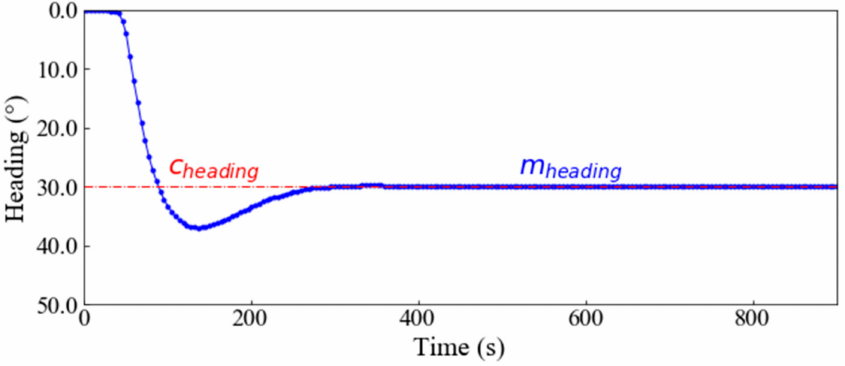
Figure 17. The heading of the glider under the control of a heading controller, which maintained the glider to a desired heading with a deadband setting of 0 ◦ .